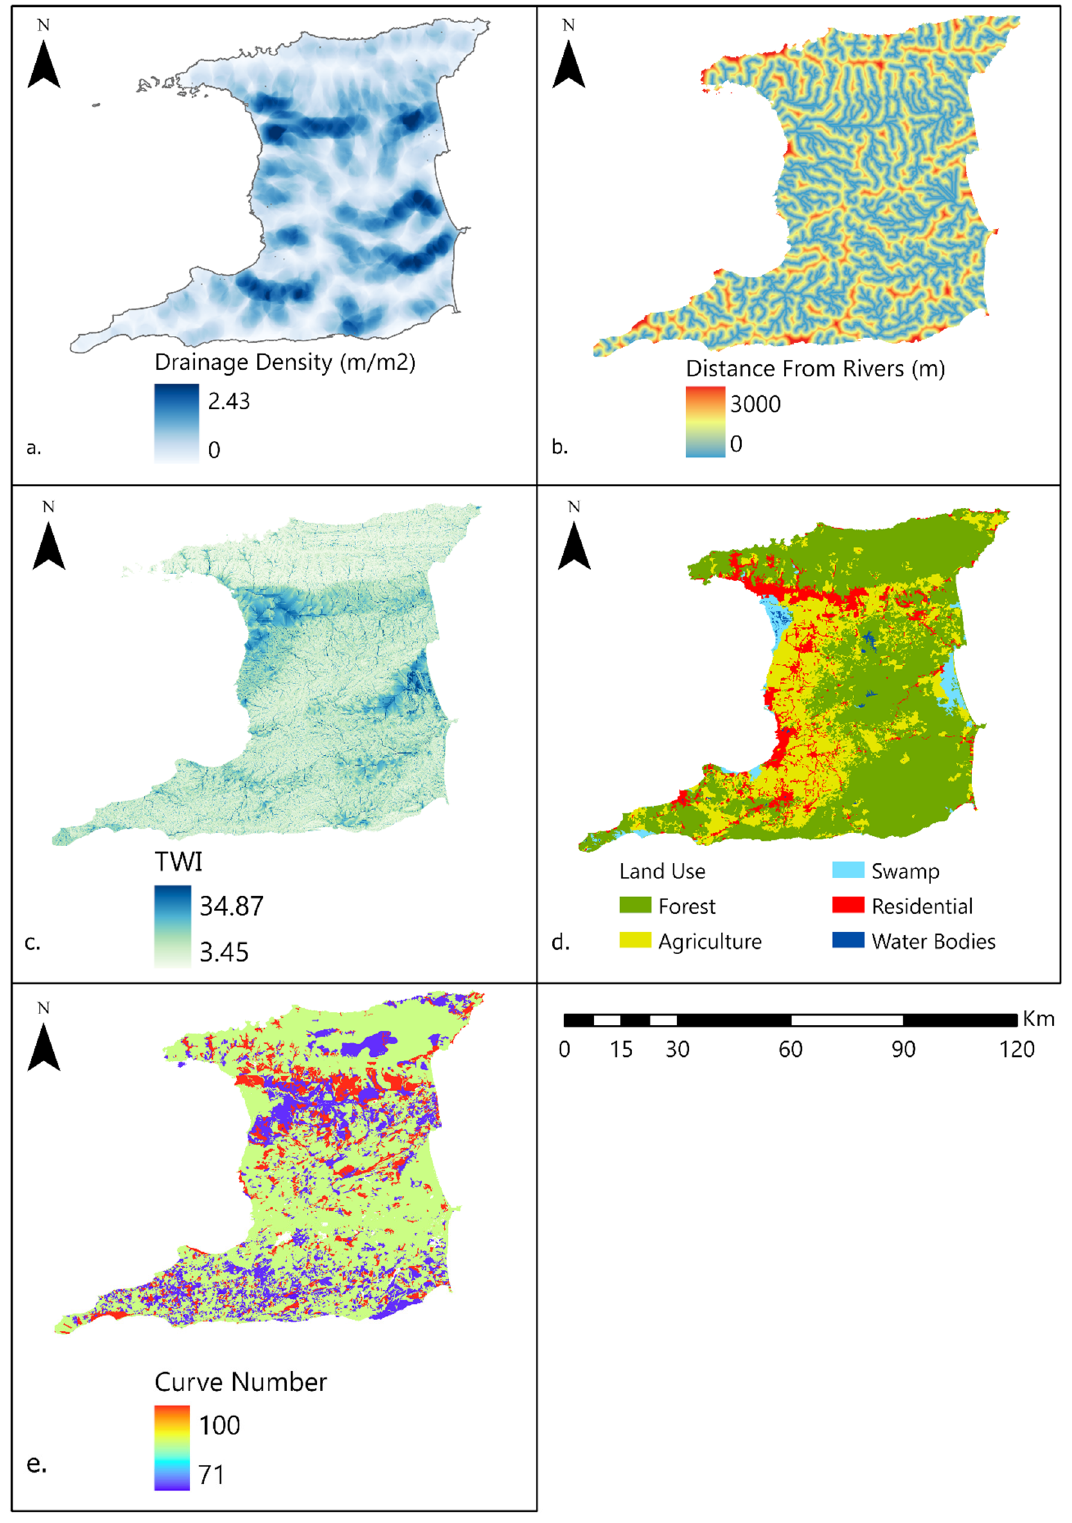
Figure 4. Conditioning factors used ( a – e ): ( a ) drainage density; ( b ) distance from rivers; ( c ) topo- graphic wetness index; ( d ) land use; ( e ) curve